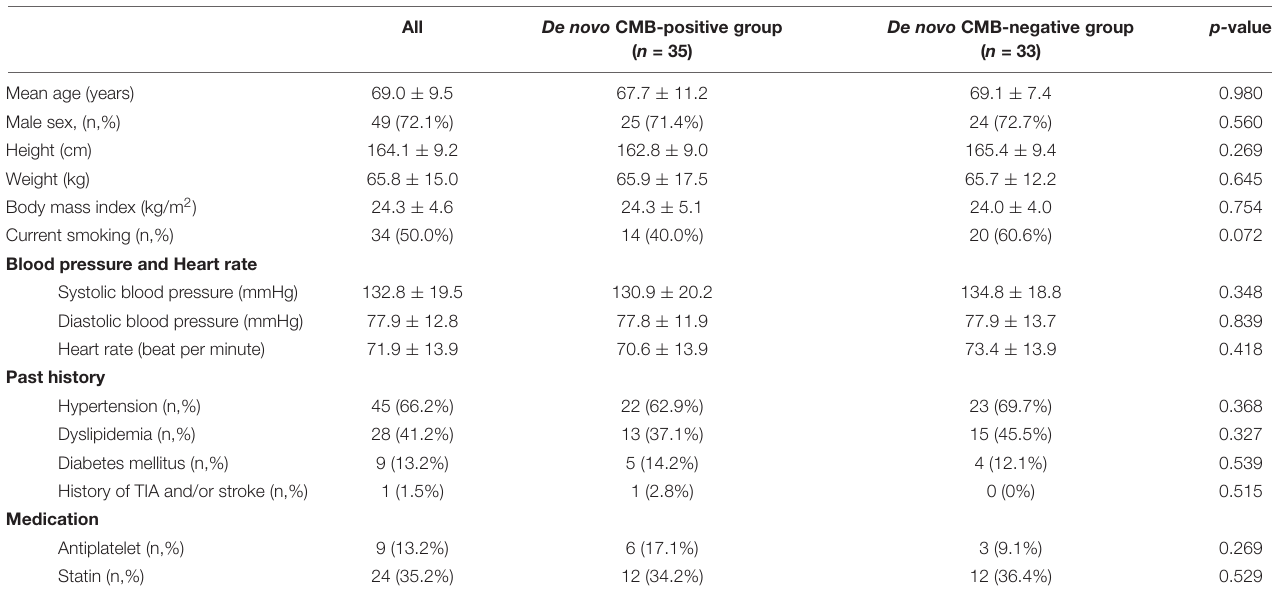
FIGURE 1 | Study protocol. TABLE 1 | Characteristics of the 68 patients with